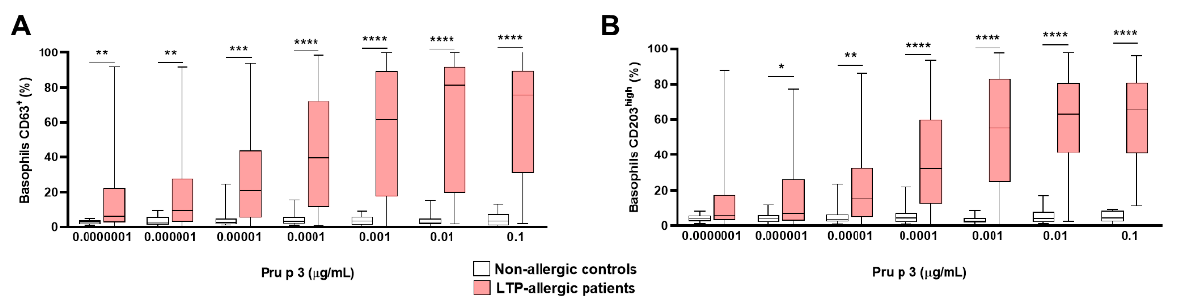
Figure 2. BAT performed with optimal doses of Pru p 3 differentiates between nonallergic controls and LTP-allergic patients. Dose–response curves were performed with seven ten-fold concentrations of Pru p 3 comparing the BAT parameters %CD63 + ( A ) and %CD203c high ( B ). Almost all Pru p 3 concentrations showed significant differences in basophil activation terms for %CD63 + and %CD203c high in patients compared to healthy controls. * p < 0.05, ** p < 0.01, *** p < 0.001, **** p < 0.0001.